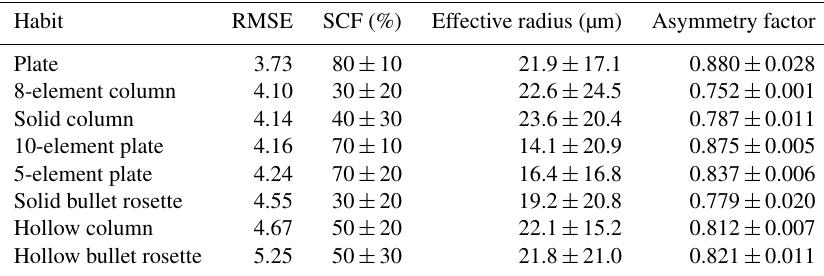
Table 3. Retrieval results evaluated for all 8d. Mean value and 1 σ standard deviation are provided for the SCF, effective radius, and asymmetry factor, sorted by increasing mean